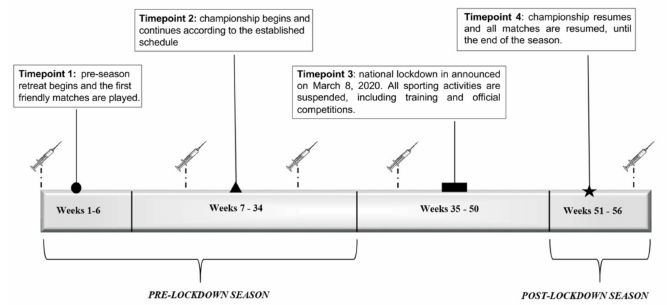
Figure 1. A timeline of the 2019/2020 Serie A season surrounding the impact of the COVID-19 pandemic